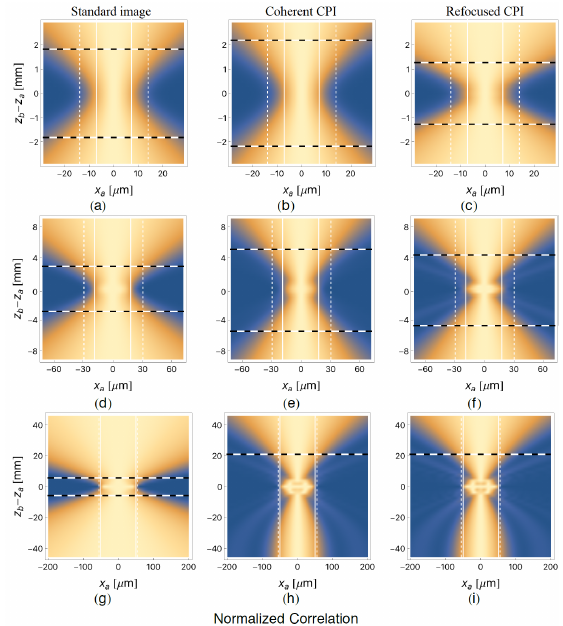
Figure 5. Comparison between the incoherent images ( a , d , g ), the coherent images from CPI ( b , e , h ), and the refocused images from CPI ( c , f , i ), for three different single-slit masks of width: a = 14 µ m = ∆ x f (top panels), a = 36 µ m (cid:39) 2.5 ∆ x f (central panels), and a = 99 µ m (cid:39) 7.2 ∆ x f (bottom panel), where ∆ x f is the diffraction-limited resolution in the focused image plane. The density plots report the correlation functions of Equations (13)–(15), normalized to their peak value. The solid (white) lines represent the size of the object, while the (white) dashed lines represent the tolerance on the blurring of the images, namely the resolution limit. The (black) dotted lines indicate the DOF limits, defined as values of the longitudinal distance at which the full width at half-maximum (FWHM) of the image increases with respect to the slit width a by the FWHM of the focused point-spread function. The setup employed for the simulation is the experimental one of Figure 10. The variations in the profile of large objects ( e , f , h , i ) are due to interference effects, related with the coherent nature of such images (from supplementary material of Ref. [42]). Reproduced with the permission from [42], copyright American Physical Society, 2017.